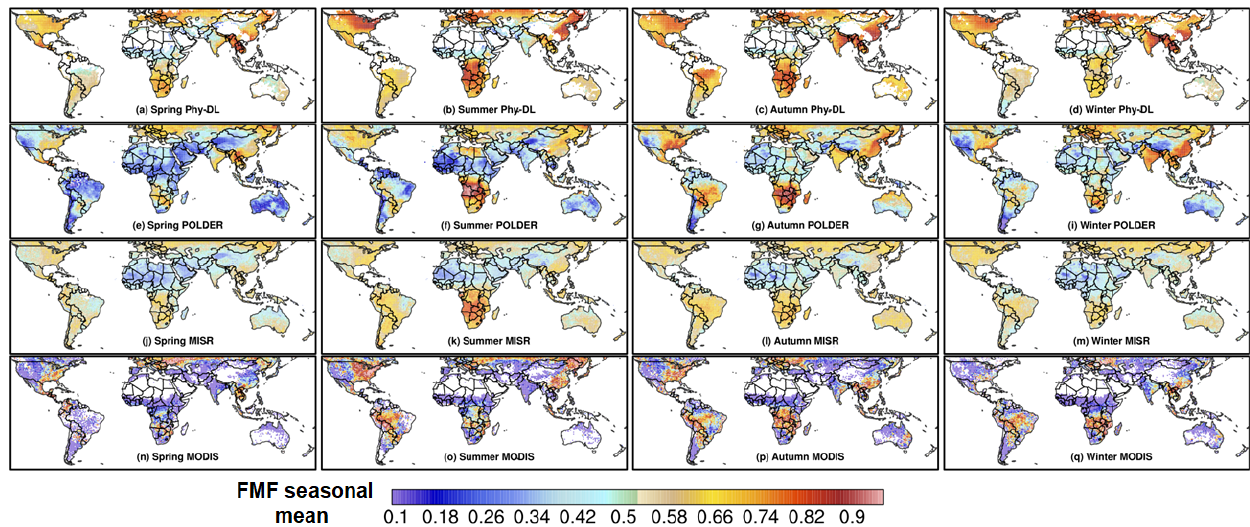
Figure 13. Seasonal mean FMF, averaged from 2008 to 2013, based on (from top to bottom) Phy-DL, POLDER, MISR, and MODIS. Columns from left to right are for spring, summer, autumn, and